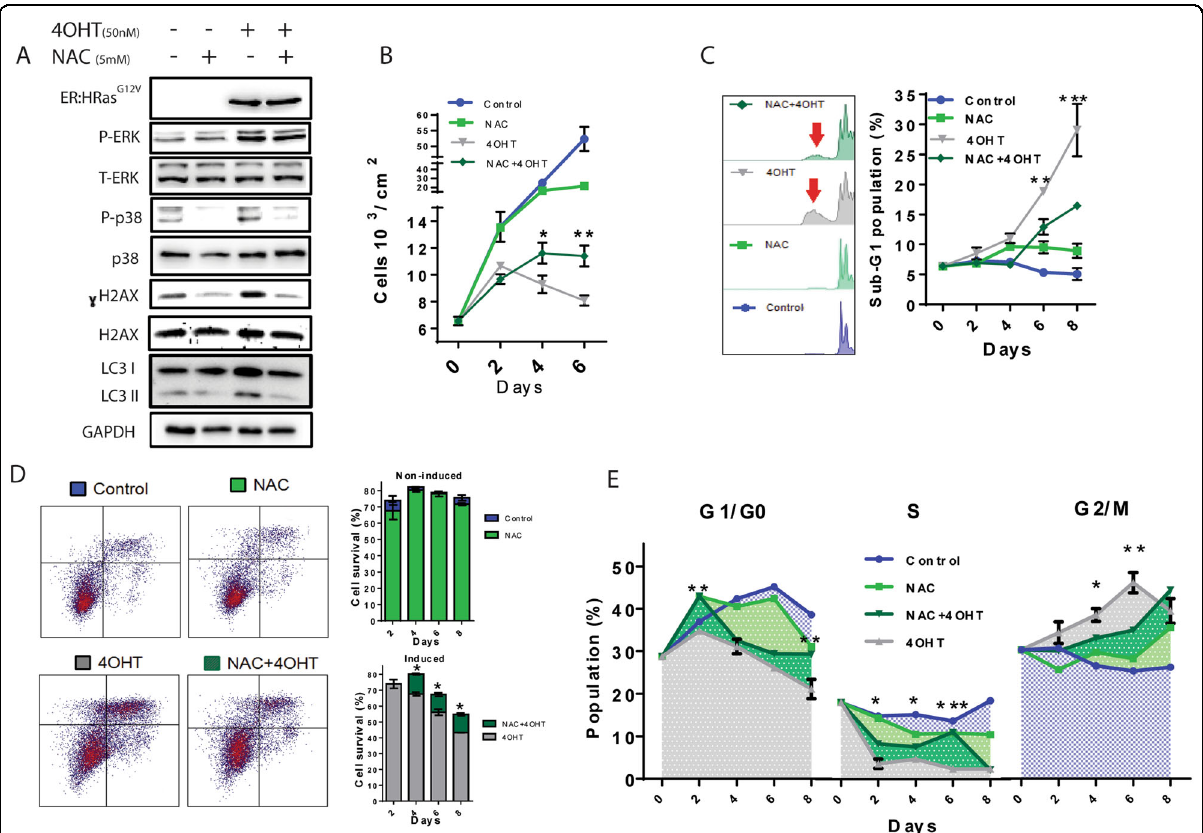
Fig. 4 The antioxidant NAC mitigated the toxic effects of HRas G12V activity, diminishing DNA damage and increasing cell viability. A Immunoblots of ER:HRas G12V keratinocytes induced for 48 h with 50 nM 4OHT, treated or not with 5 mM of NAC. B Growth curves of ER:HRas G12V keratinocyte induced or not, showing the protective effect of NAC on cell proliferation. The graph is representative of two independent experiments carried out in duplicate. C DNA content by PI- fl ow cytometry analyses showed that NAC increased cell viability, evidenced by the elimination of the sub-G1 population on the 8th day of induction. The graph is representative of two independent experiments. D Annexin-V/PI- fl ow cytometry cell viability assays: quanti fi ed density plot graphs also demonstrated NAC survival effect on ER:HRas G12V keratinocytes induced with 4OHT. Density plots are presenting the pro fi le of keratinocytes treated or not with 4OHT on their 8th day. The graph is representative of two independent experiments. E PI- fl ow cytometry cell cycle analyses showed that NAC-treated ER:HRas G12V keratinocytes could overcome the G1 and G2/M cell cycle arrest caused by high HRas G12V activity. The signi fi cance presented in the graph is related to the comparison between cells induced with 50 nM of 4OHT with (dark green) or without (gray) NAC treatment. The graph is representative of two independent experiments. For fl ow cytometry, 30 × 10 3 cells were considered per condition and time point. Data presented as mean (SD). Two-way ANOVA * P ≤ 0.05, ** P ≤ 0.01, and *** P ≤ 0.001, Bonferroni post